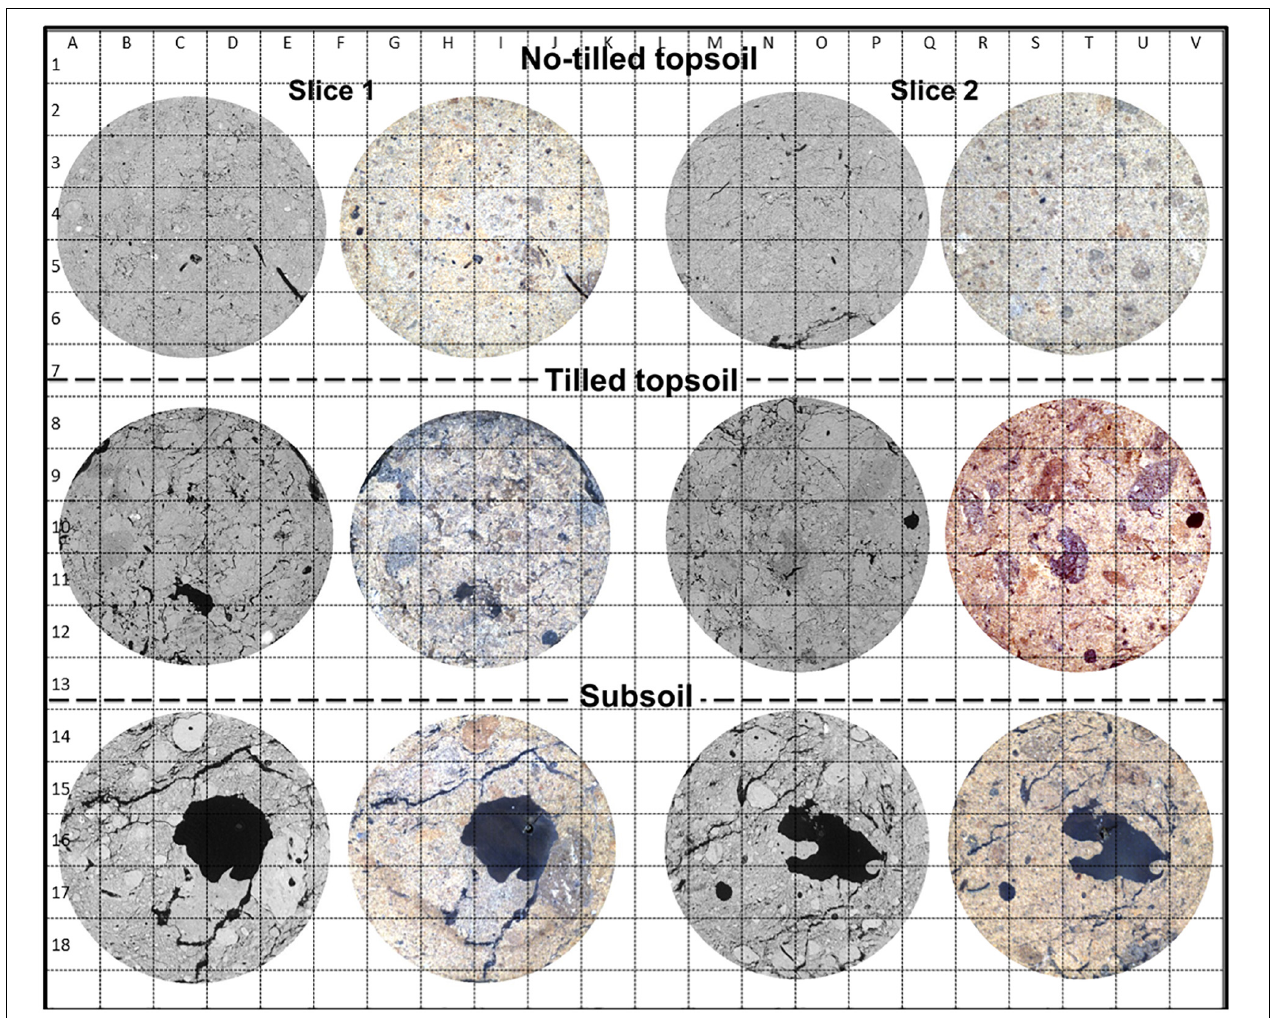
FIGURE 4 | Image pairs of registered 2D slices of µ CT (gray) and imVNIR images (visible spectra). Gray values of µ CT represent dense areas (white) and pores (black). The pores in the imVNIR images can be black or light colored, since the resin used is